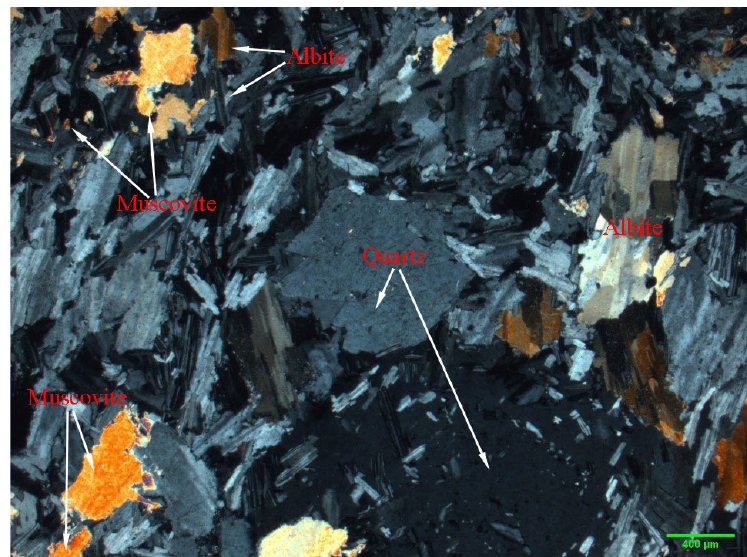
Figure 3. Hand specimens of the ore. (The ore is gray–white with a massive and coarse ‐ grained structure. Coarse feldspar and quartz particles, and glassy muscovite particles are visible.).